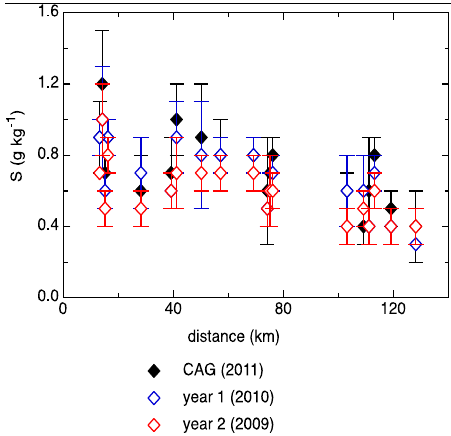
Figure 2. Site averaged total S contents in CAG, year 1, and year 2 needles versus distance to the main oil sands operations.